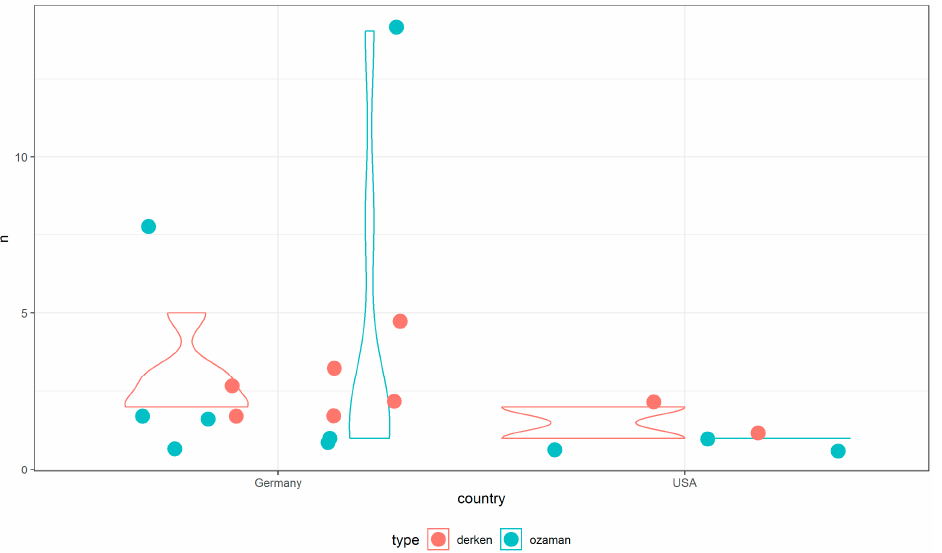
Figure 7. Violin plot for individual participants’ use of the temporal connector o zaman and derken 9